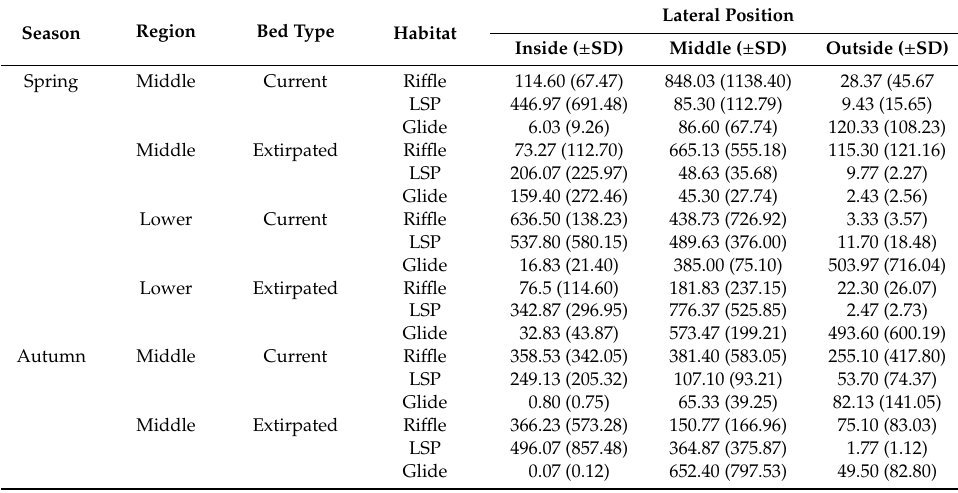
Table A6. Mean bedload discharge (g · s − 1 ) ( ± SD) by lateral position (Inside, Middle, Outside) across seasons (Spring, Autumn, Winter), regions (Middle, Lower), bed type (Current, Extirpated), and habitat (Ri ffl e, LSP,